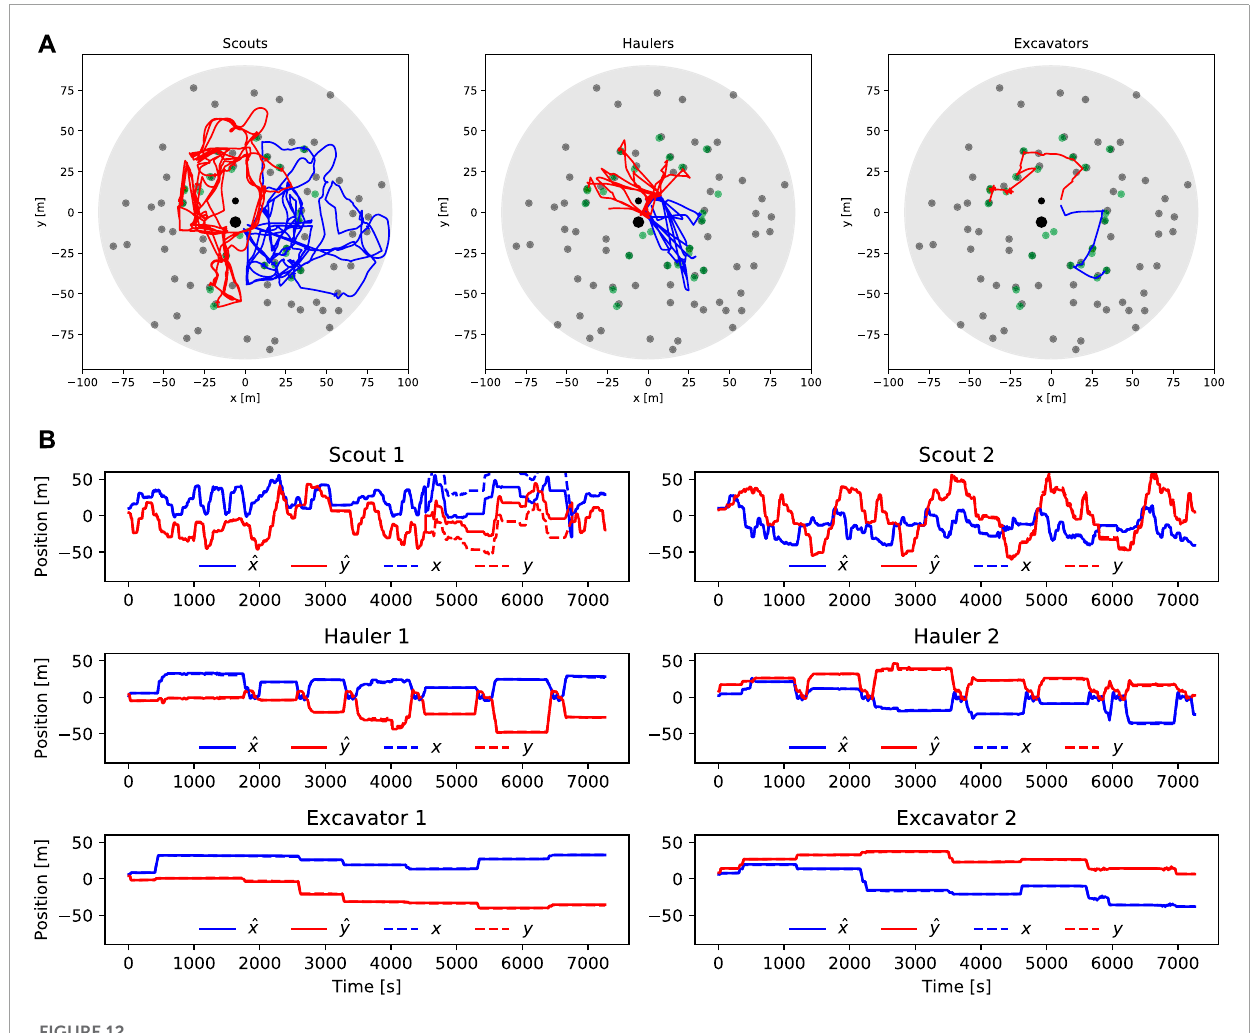
FIGURE 12 Localization during a two-hours mission for multiple robots. (A) Truth trajectories during the two-hours simulation for all six robots. (B) Estimated (solid lines) and truth (dashed lines) trajectories during the two-hours simulation for all six